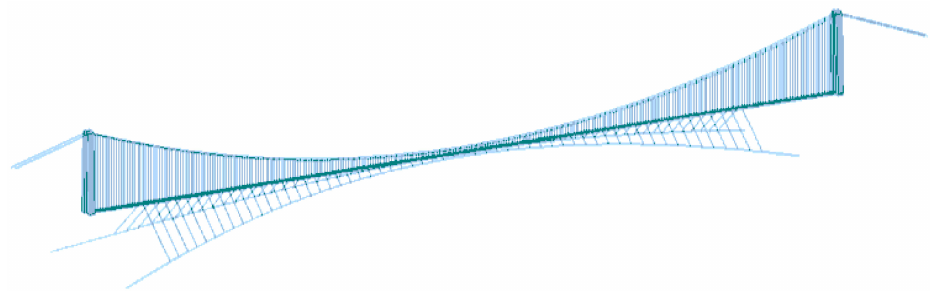
Figure 3. FEA model of the